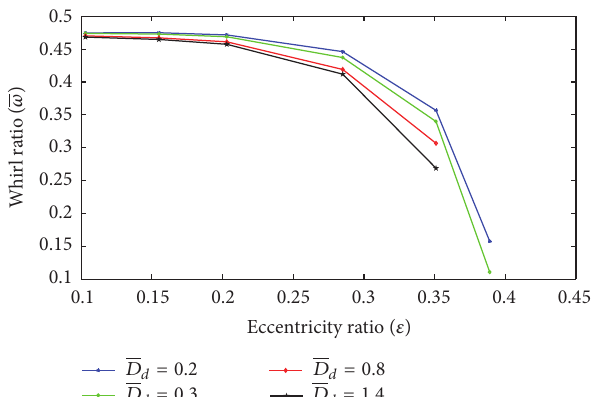
Figure 24: Effect of dam depth ratio on whirl ratio.